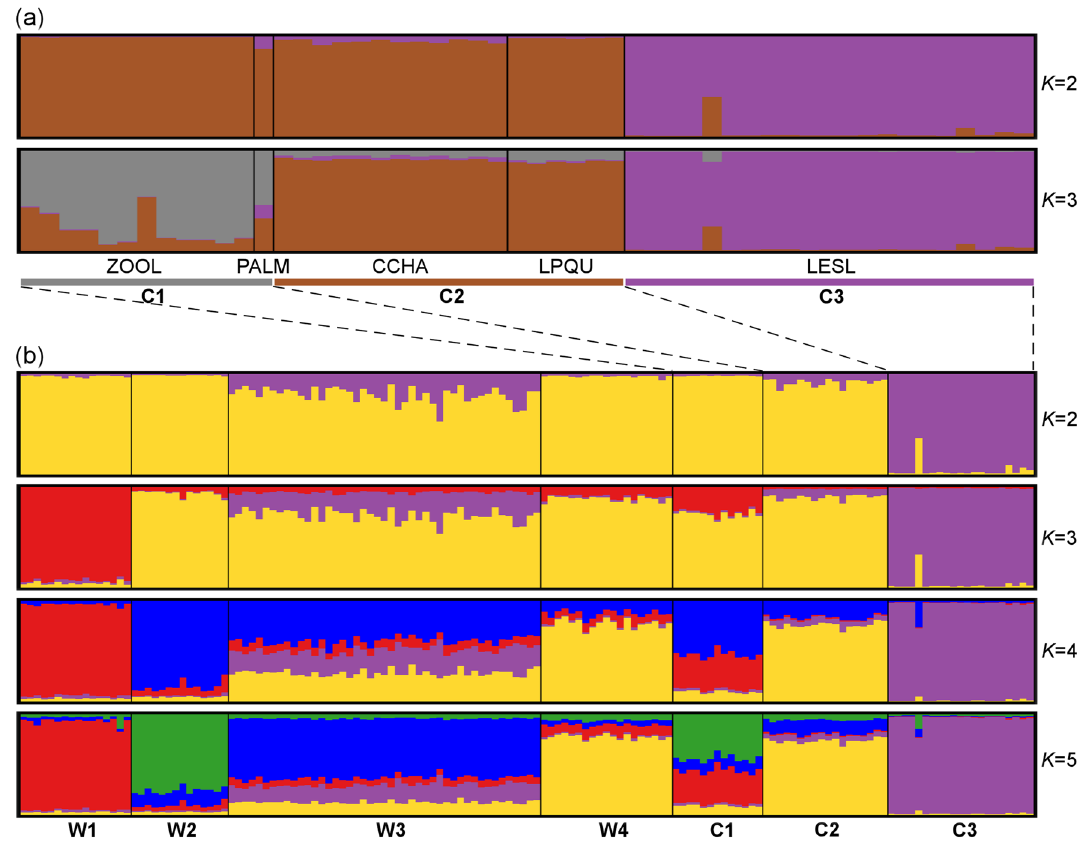
Figure 2. ( a ) Distinct genetic clusters from the Bayesian clustering analysis with prior information on sampling location are shown for several K clusters for captive red-fronted macaws, where the optimal number of clusters was estimated for K = 3. ( b ) Clustering analysis combining captive and wild individuals, where the optimal number of clusters was estimated for K = 5. Each vertical line corresponds to one individual and the different colours represent the assignment to each cluster. Colours assigned to each cluster correspond to the genetic clusters obtained for the wild population (see Fig. 1), except for the cluster C3 that cannot be assigned to any cluster in the